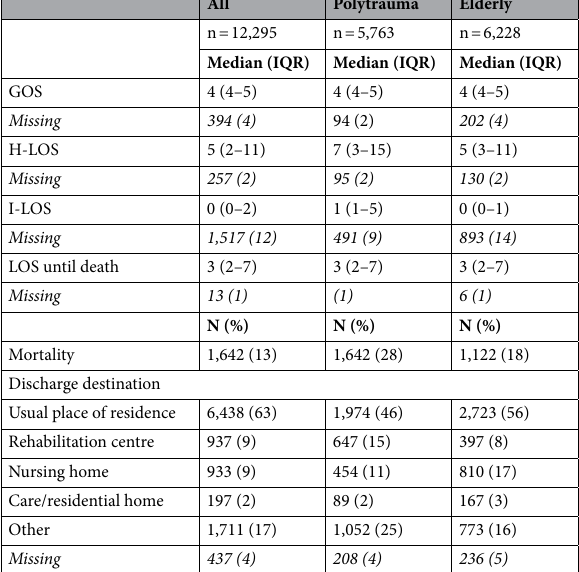
Table 3. Hospital outcome parameters. H-LOS = Length of stay in hospital, I-LOS = Length of stay in Intensive Care Unit, GOS = Glasgow Outcome Scale score.